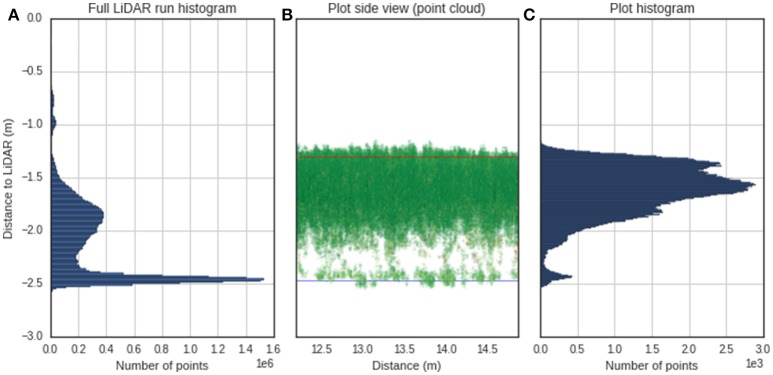
Determination of canopy height from LiDAR. (A) Histogram of distance relative to the LiDAR for a typical column of plots on the 23/10/2014. The peak of the histogram is selected as the height of the ground. (B) Side view of point cloud for a single plot from the same column as (A), where the x-axis is the distance traveled by the Phenomobile Lite along the column. The blue line represents the ground obtained as the peak of the histogram, and the red line represents the height for the 0.955 quantile. (C) Histogram for the same single plot as (B) where the user has selected the region of interest.